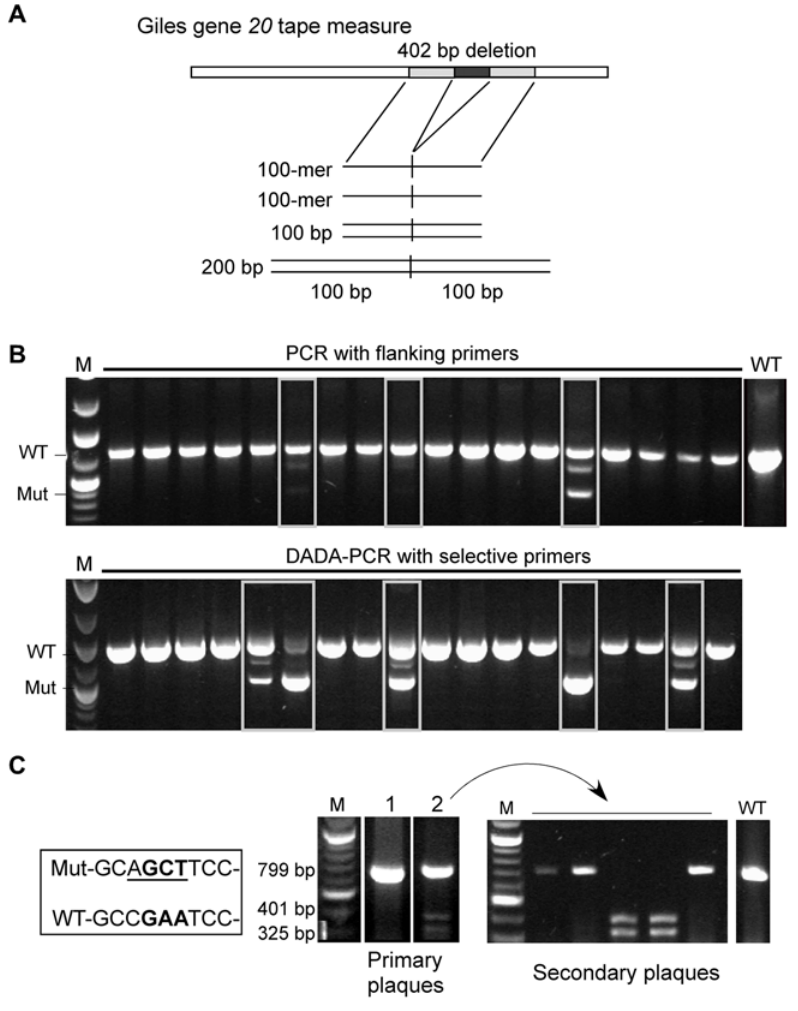
Figure 2. Use of BRED to construct internal deletions and point mutations in the tape measure gene of mycobacteriophage Giles. a. Schematic illustration of substrates used for recombineering. b. M. smegmatis mc 2 155:pJV53 cells were co-transformed with 50 ng Giles DNA and a 200 bp dsDNA deletion substrate (300 ng), plaques were recovered and PCR-screened with flanking primers (top gel) or selective primers (lower gel) as indicated. Samples containing mutant genomes in addition to wild-type DNA (boxed lanes) are detected by both methods, but are detected more frequently by selective DADA-PCR. Pools containing the deletion were re-plated, and plaques were screened for pure populations of mutant phage by flanking PCR (not shown). c. Base substition mutations, which change a glutamate (GAA) codon to an alanine (GCT) and incorporate an AluI restriction site for screening (boxed sequence), were engineered into Giles gene 20 using a 70 bp dsDNA substate (200 ng) co-transformed into mc 2 155:pJV53 cells with 50 ng Giles DNA. Two primary plaques from the initial screening are shown ( # 1, # 2) one of which ( # 2) has products of Alu I cleavage. Secondary plaques recovered from the mixed plaque were screened, and the wild-type and two mutant plaques are shown.